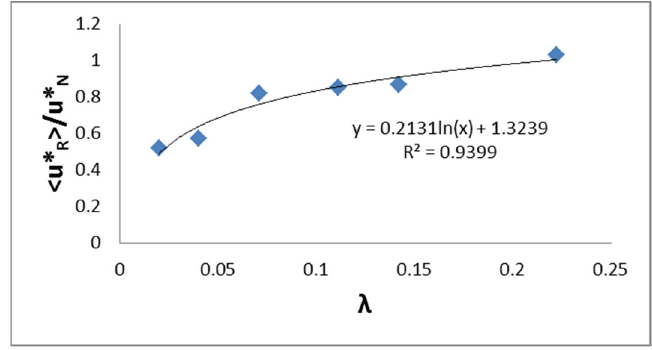
Figure 6. Variation of <u* R >/u* N with